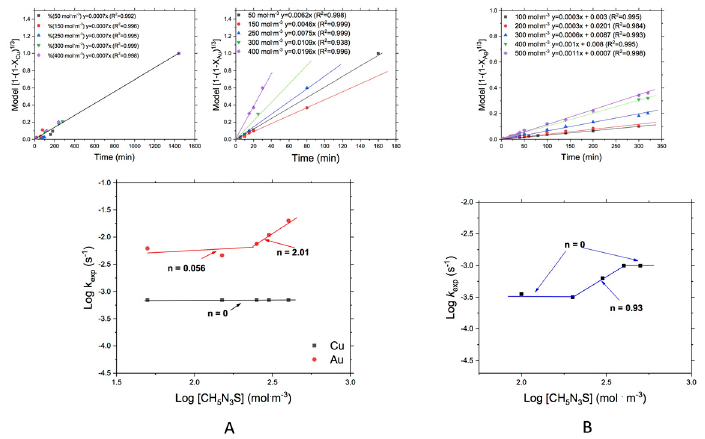
Figure 5. Leaching of ( A ) Au and Cu from WEEE, and ( B ) Ag from MW. Effect of [CH (cid:2873) N (cid:2871) S] . The effect of [CH (cid:2873) N (cid:2871) S] concentration on the Ag leaching rate from MW (Figure 5B),